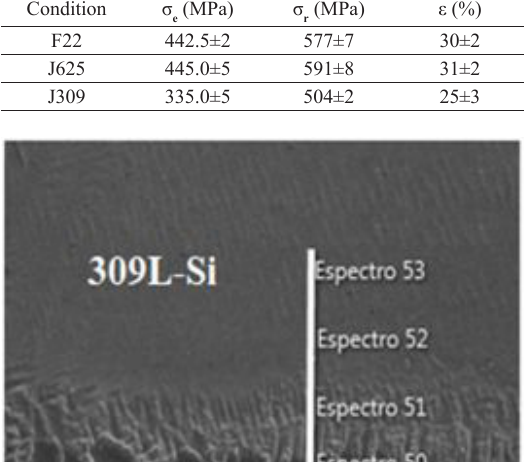
Figure 7. Schaeffler Diagram, alloy composition on 309L/INC625 interface and of 309L alloy on bevel filling.